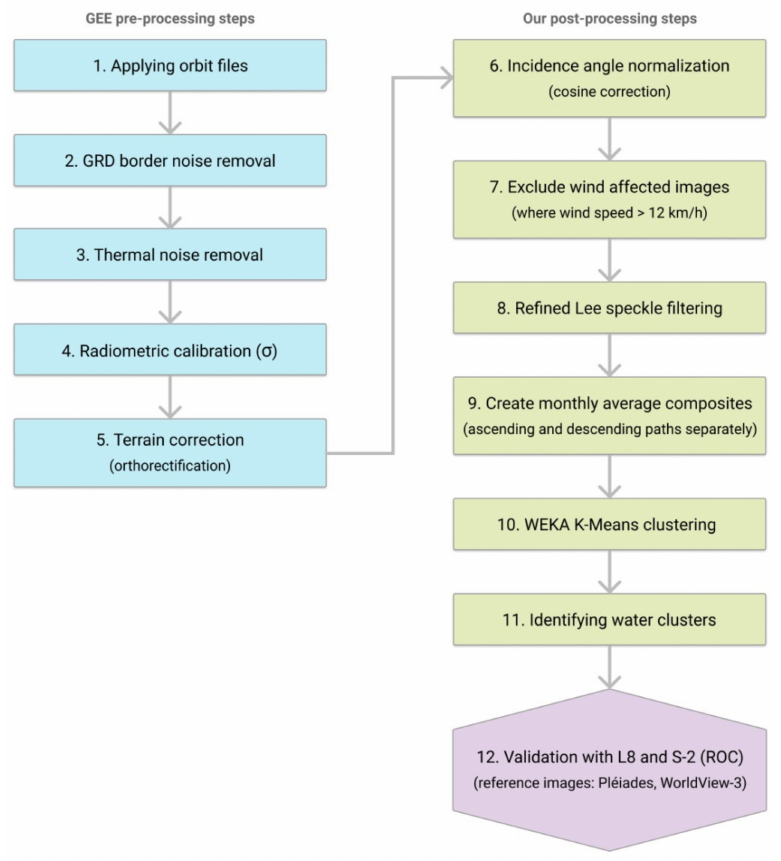
Figure 3. Flowchart of the data processing steps applied to Sentinel-1 data. The pre-processing steps